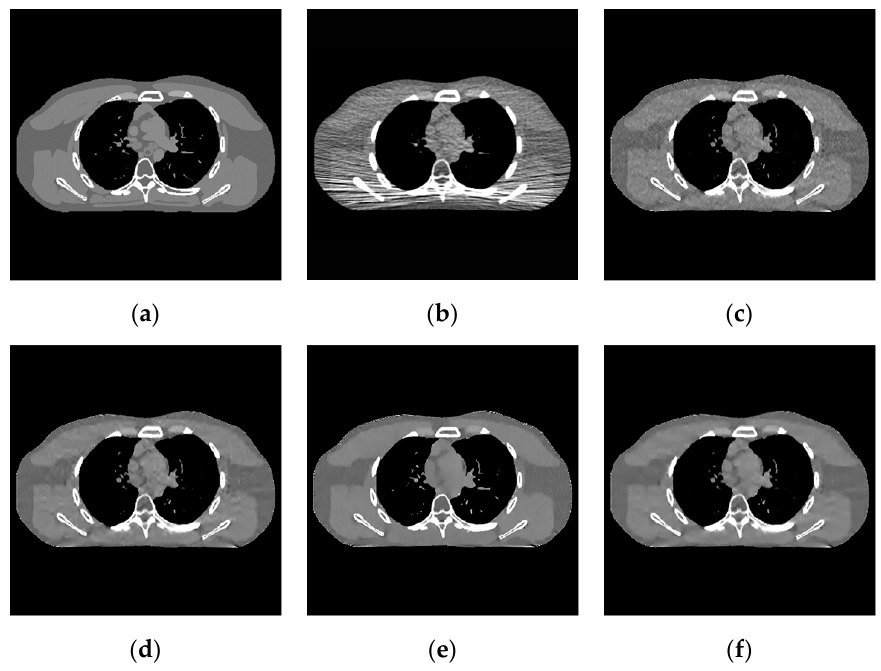
Figure 7. Image of the difference of incident photon number 10 (cid:2872) . ( a ) real image; ( b ) FBP reconstruc- tion; ( c ) EP iterative reconstruction; ( d ) DCT image post-processing; ( e ) DL iterative reconstruction; ( f ) learned sparse transformation.